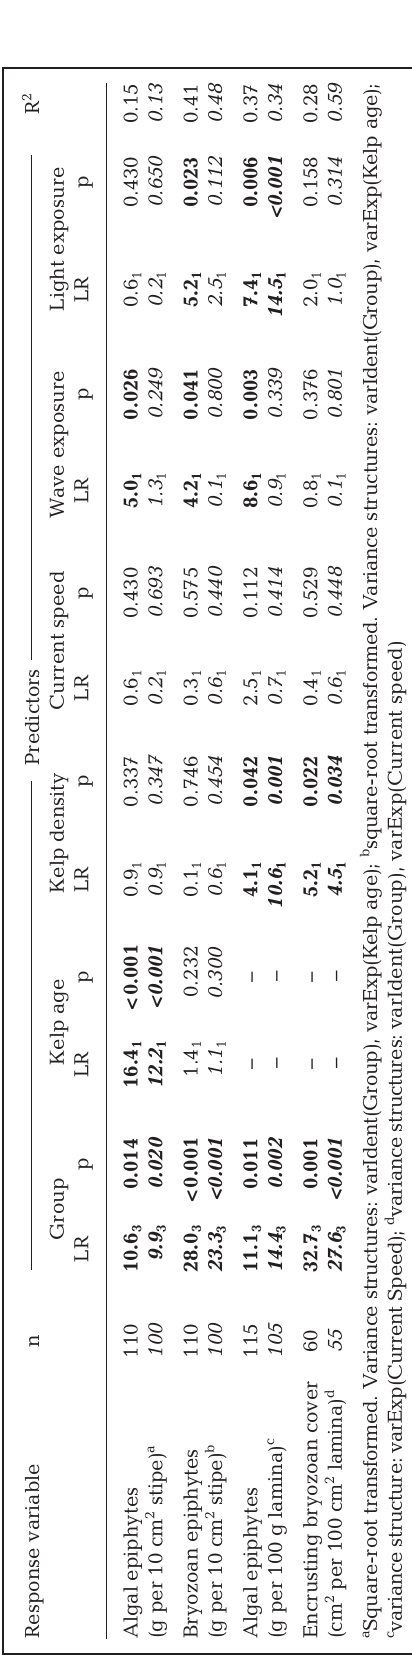
i va r e n s o p e s R